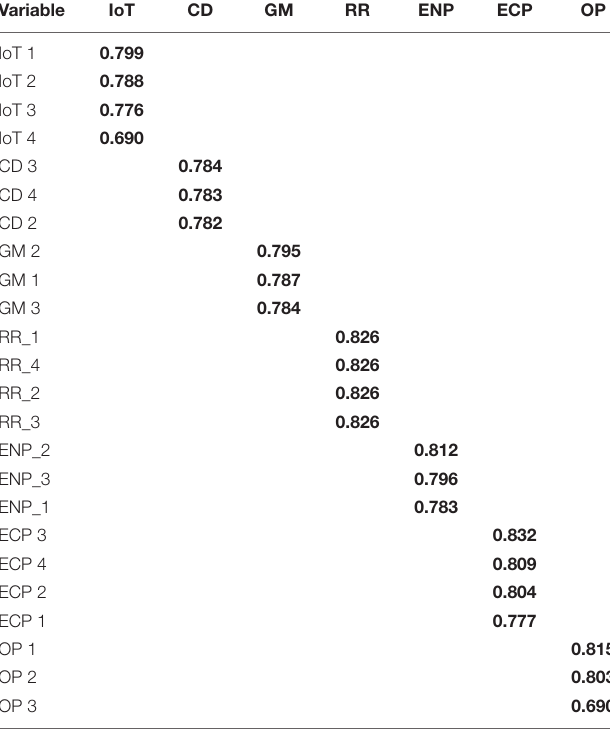
TABLE 9 | Factor analysis.